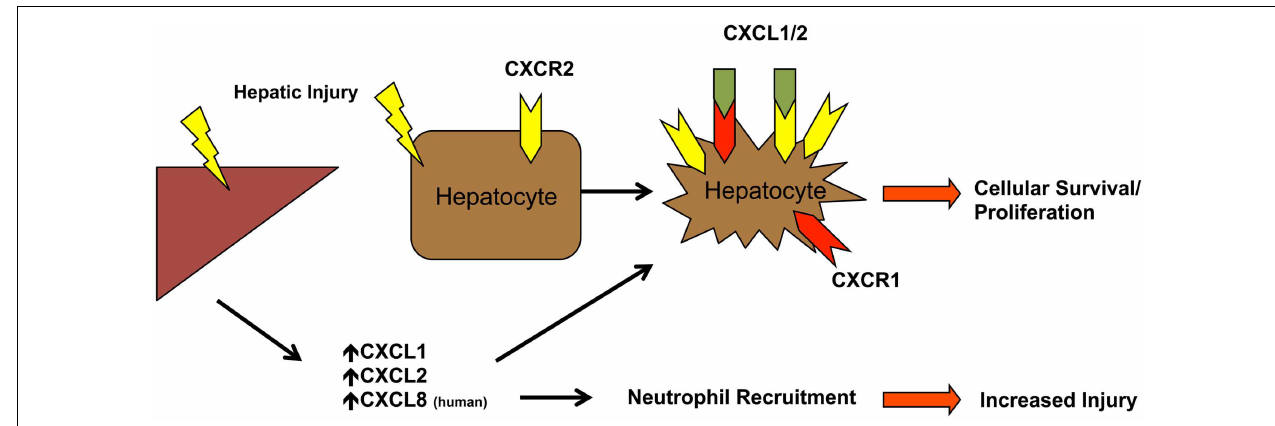
humans). Hepatic injury also promotes expression of CXCR1 and increased expression of CXCR2 on hepatocytes. Receptor engagement leads to changes in hepatocyte survival and proliferation in a dose dependent